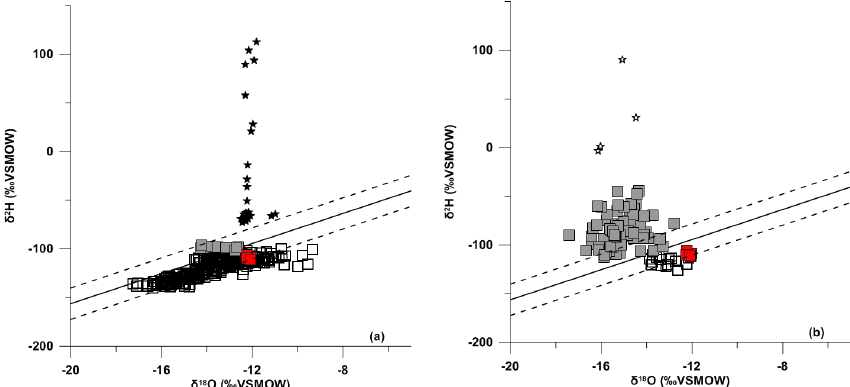
Figure 2. Cross-plot of the δ 18 O and δ 2 H values of pore water from Cretaceous shales and drill fluids at two drill sites near Esterhazy, Saskatchewan, Canada. Solid grey squares and open black squares represent contaminated and uncontaminated samples, respectively, trimmed in the field (a) and trimmed in the laboratory (b) . Solid red squares represent the source water for rotary drilling, and solid and open stars represent isotopically spiked drill waters for core holes for samples trimmed in the field and laboratory, respectively. The local meteoric water line (LMWL) for Saskatoon, Saskatchewan, is also presented with associated 95% confidence intervals (after Hendry et al., 2013). Gravimetric water content of all samples ranged from 7.8 to 31.3% ( n =